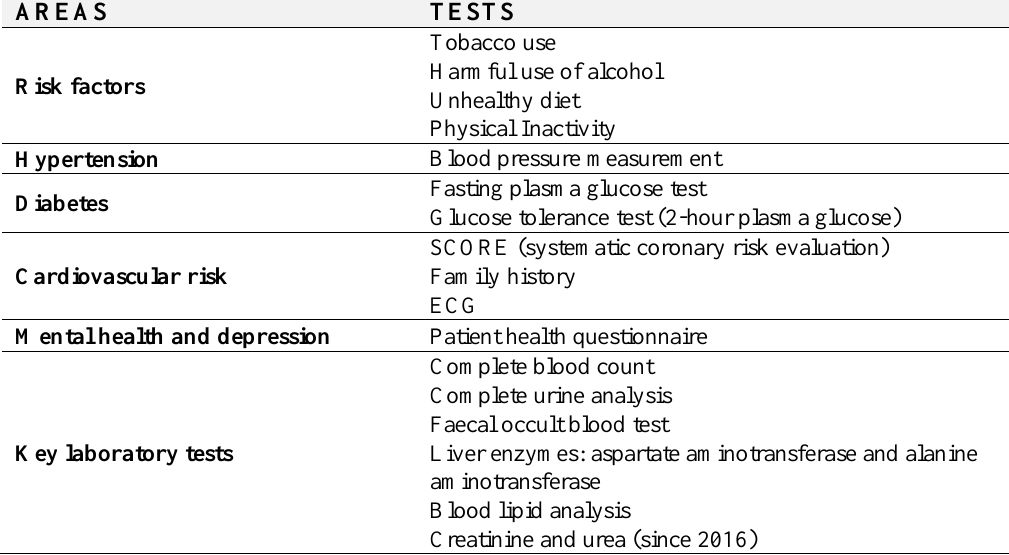
Table 1. Tests provided in six priority areas of the check-up programme ( Source: reference number